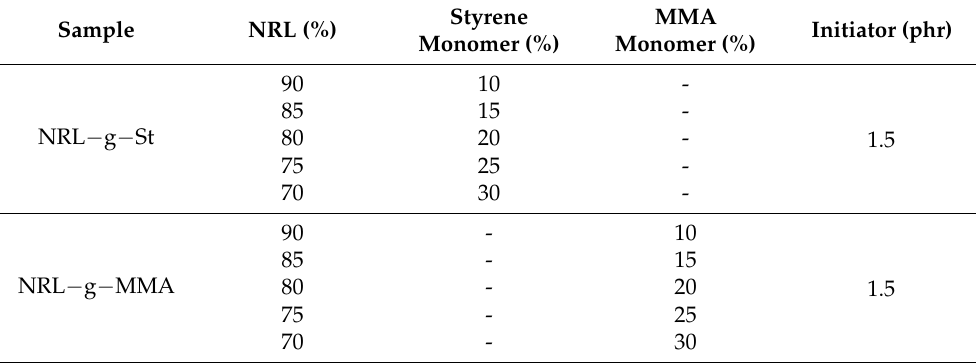
Table 1. Composition of Synthetic Materials NRL − g − ST and NRL − g −